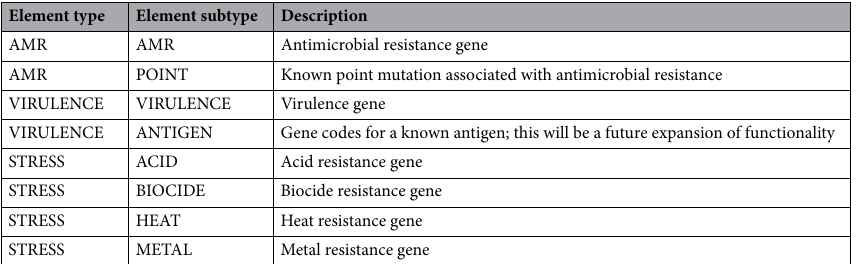
Table 1. Current combinations of type and subtype fields in the Reference Gene Catalog. Note that “resistance” is used as a shorthand for significantly decreased susceptibility, and does not necessarily mean that the gene will confer clinical